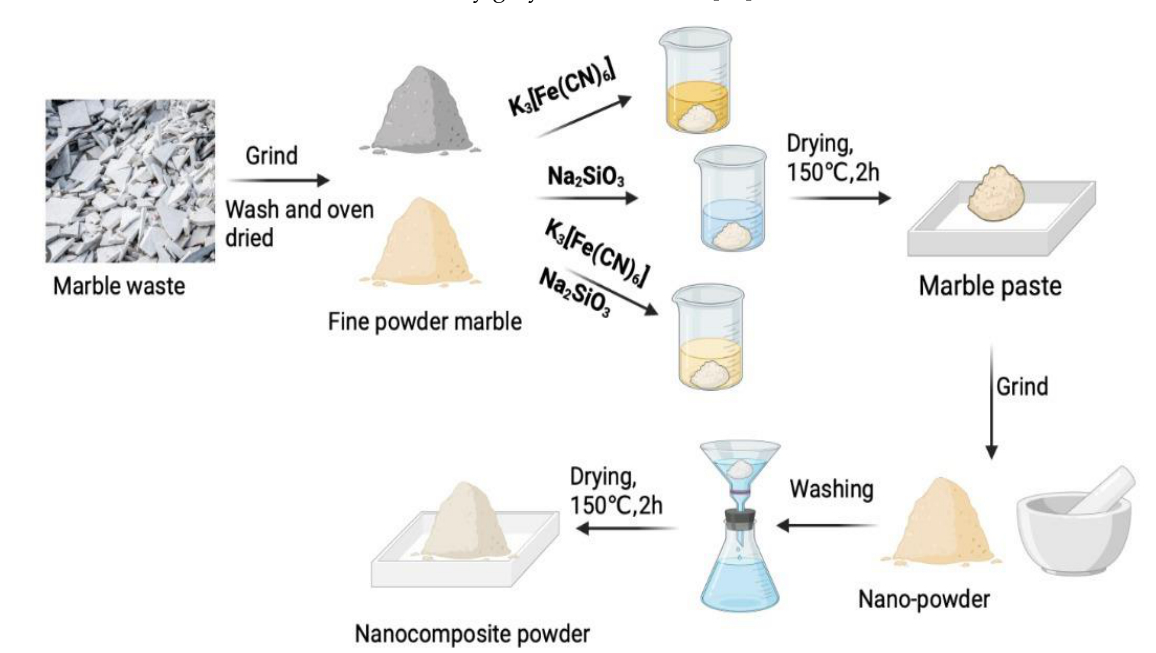
Figure 1. Synthesis of nanocomposite from marble waste.